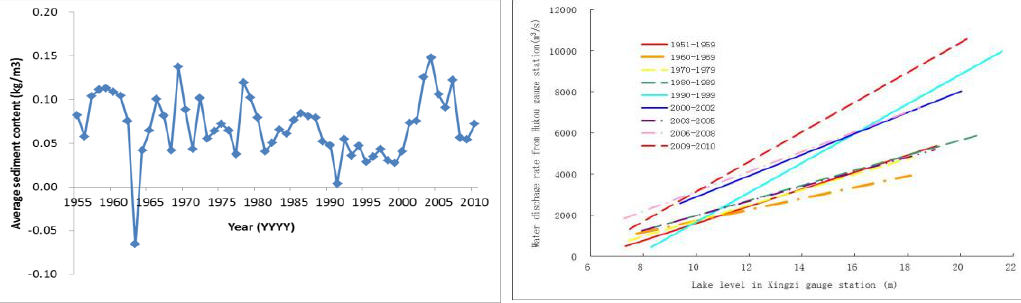
Figure 7: Changes of relationship between lake level and Figure 6: The yearly average loaded sediment content rate of water discharge from Poyang Lake into Yangtze discharged to Yangtze River from Hukou of Poyang River during 1951-2010 Lake